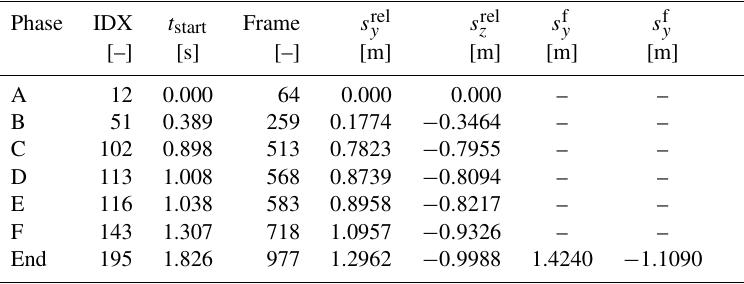
Figure 4. Movement characteristics and high-speed captures. (a–c) Time series of the derived movement characteristics for (a) translational acceleration, (b) translational velocity and (c) translational displacement (with detail). The three curves in each plot give calculated time- dependent values for each axis of the relative reference system (as defined in Sect. 2.2). Motion phases and distinct time points are indicated as in Fig. 3. In (c) green and blue dots indicate the true displacement components in y f and z f directions measured by means of a laser distance meter (for explanation see Sect. 2.2). (d) High-speed captures at time points diamond I and II. The data of (a–c) were recorded with pebble 4, which is highlighted in light yellow and labelled in (d) . Table 2. Motion phases of pebble 4 as displayed in Figs. 3–5 and high-speed video. IDX gives the index of data samples, and t Start gives the time in seconds since the start of motion. Frame is indicated by the frame number as displayed in Video 1. For other columns see description within the